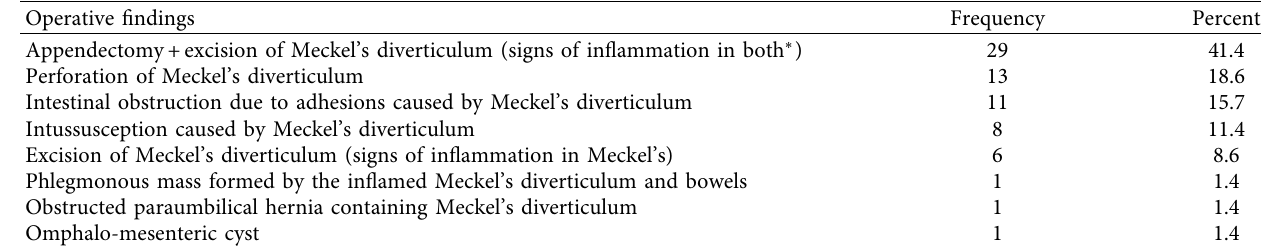
Table 3: Showing the intraoperative